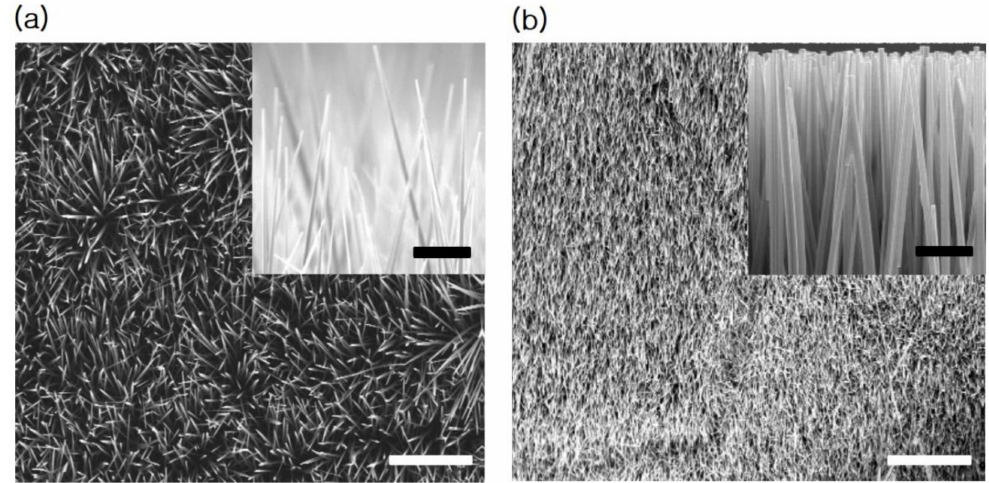
Figure 3. Cross-sectional view of FE-SEM (field emission-scanning electron microscopy) images (the scale bar is 20 µ m) for the ZnO NRs grown on ( a ) Cu sheet and ( b ) graphene/Cu sheet using the CVD method. The inset is an enlarged view of corresponding FE-SEM images (the scale bar is 1 µ m).